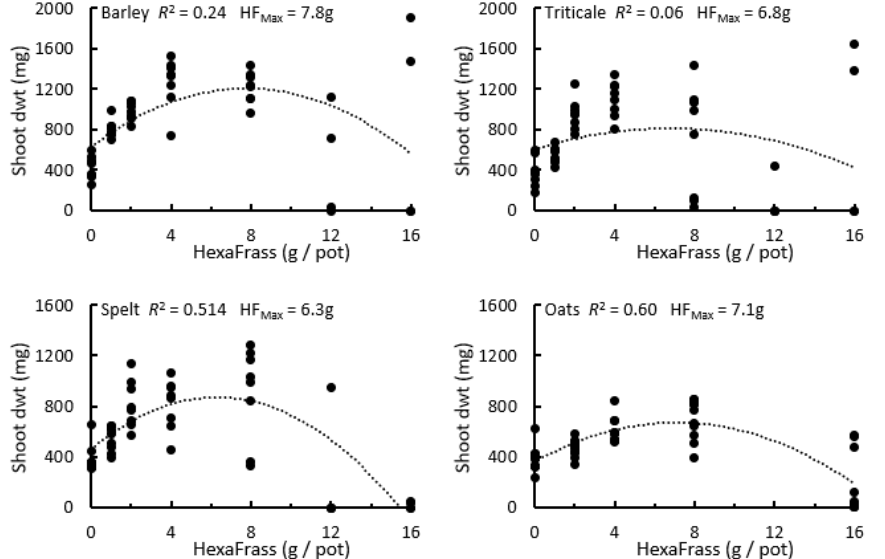
Figure 2. The relationships between shoot dry weight (dwt) of barley, triticale, spelt, and oats with application rate of HexaFrass (g/pot). Plants that did not survive until harvest were assigned a shoot dry weight of zero. HF Max is the application rate producing the predicted maximum shoot dwt. linear relationships with HF application rate (Figure 2). For spelt ( R 2 = 0.51) and oats ( R 2 = 0.60) these relationships were well described by quadratic functions. For barley ( R 2 = 0.24) and triticale ( R 2 = 0.06), however, these patterns were not so clear, largely because half of plants in the 16 g HF treatment did not survive, but the surviving plants still produced very high shoot dry weights (Figure 2). Based on the fitted polynomial curves, the esti- mated optimal HF application rates in this experimental system were all between 6 to 8 g per pot: 6.3 g/pot for spelt, 6.8 g/pot for triticale, 7.1 g/pot for oats, and 7.8 g/pot for barley. For the cereals where shoot dry matter (DM; %) was examined (barley, triticale, spelt), there were non-linear negative relationships between the HF application rate and the DM content (Supplementary Document S2).